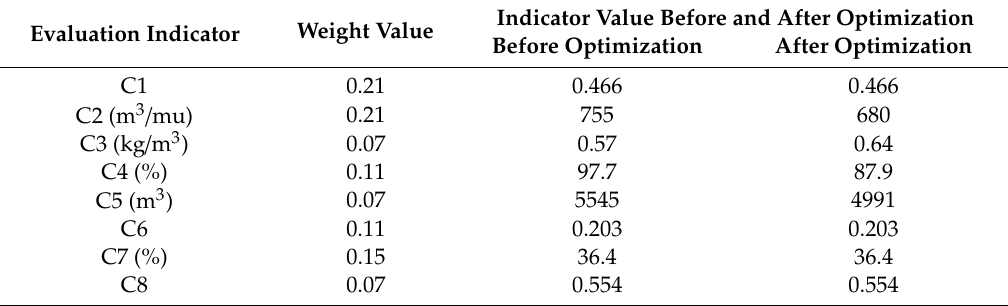
Table 9. Evaluation indicators values before and after optimization in